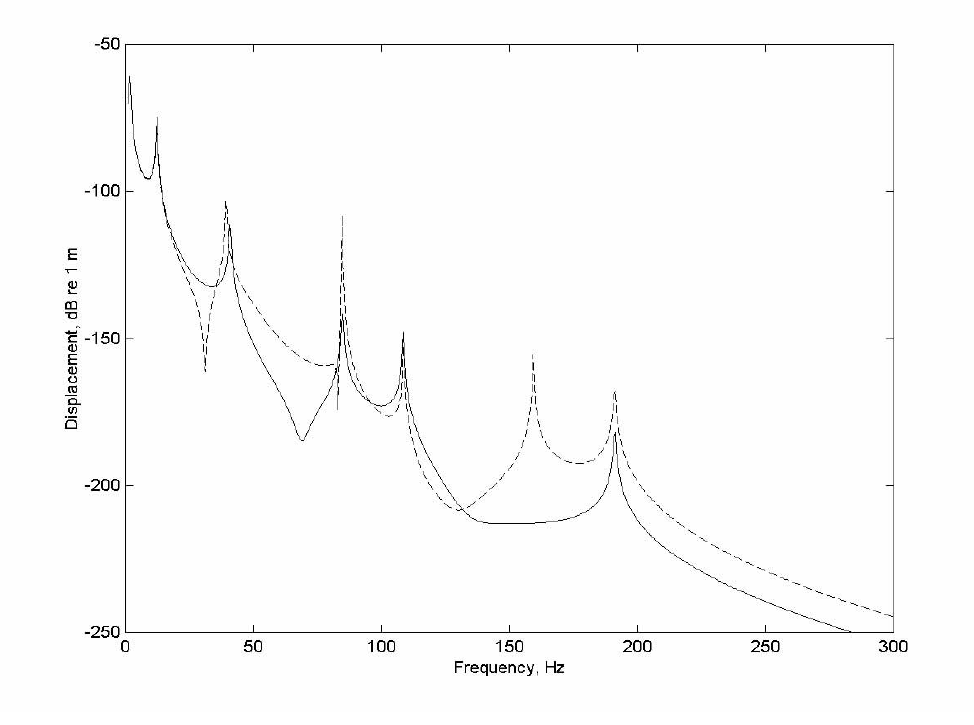
Fig. 3. Results using the Matrix Inversion Method. —— Case III (with M 1 ) ≡ Baseline; ––– Case IV (without M 1